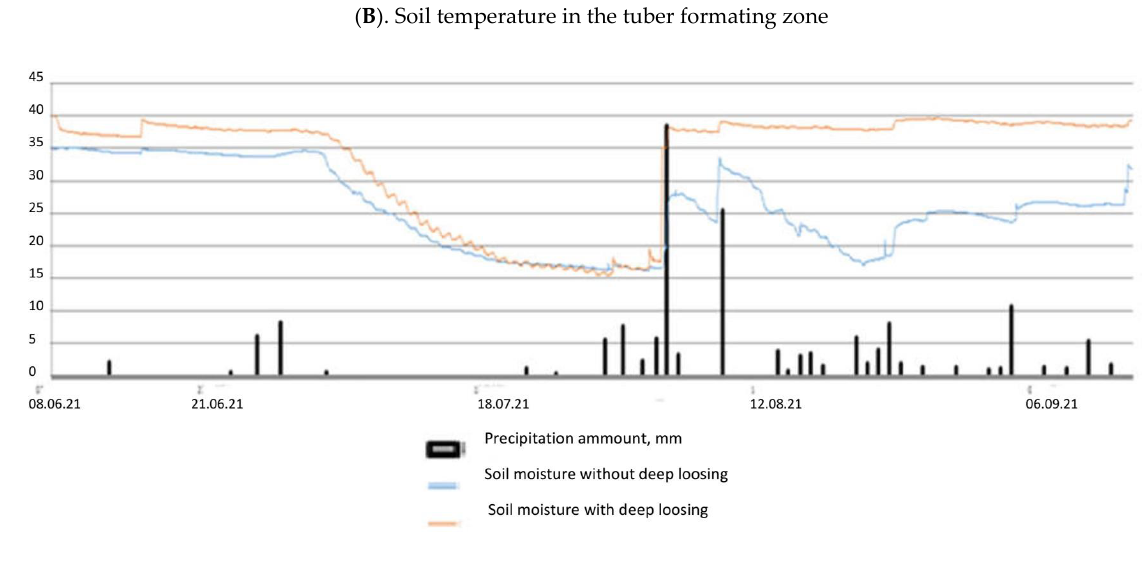
Figure 1. Air and soil temperatures ( A , B ) and soil moisture ( C ) in the tuber forming zone during the period of active potato development in 2021. period of active potato development in